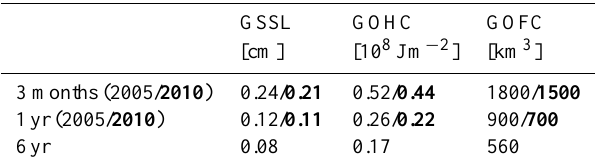
Table 1. Uncertainties of GOIs during 2005 and 2010 (bold) for different time averages, i.e. 3 month, 1yr and 6yr. See text for more details. These values do not take into account uncertainties induced by remaining systematic errors in the Argo observing